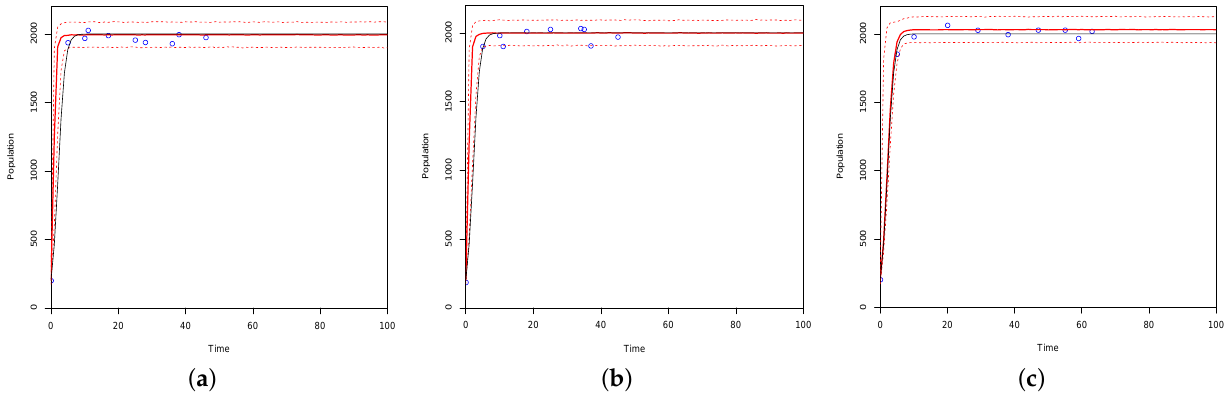
Figure 9. 10,000 MCMC samples are used in this simulation of a rapid growth curve increasing at a 100% rate across 100 time points with a carrying capacity of 2000. Sequential optimality is used to find the ten best points for ( a ) I, ( b ) A Φ and ( c ) D Φ optimal designs. The optimal points are plotted in blue and fit with a solid red curve. The red dotted lines represent the 2.5% and 97.5% quantiles of the predicted values of the model. The black curve represents the ground truth model.